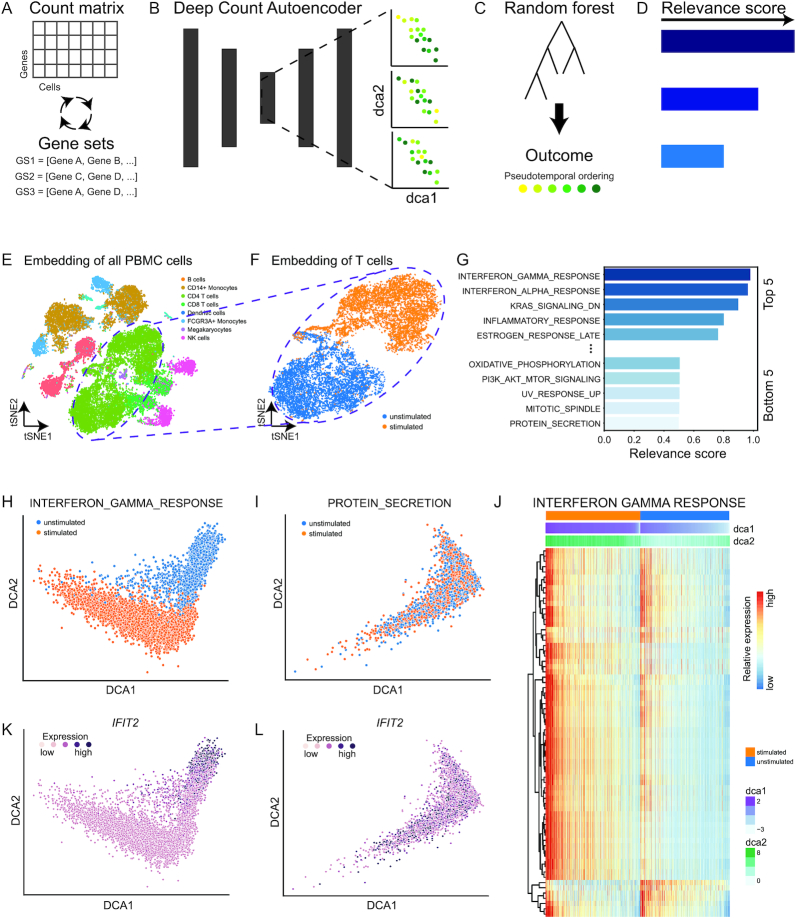
DrivAER correctly identifies interferon response. (A) DrivAER iteratively subjects annotated gene sets to unsupervised dimension reduction via Deep Count Autoencoder (DCA). (B) For each gene set, the 2D data manifold coordinates are calculated and (C) subsequently used as input features in a random forest model to predict the outcome of interest (i.e., pseudotemporal ordering). (D) The random forest prediction accuracy represents the relevance score. (E) t-Distributed stochastic neighbor embedding (tSNE) visualization displays all peripheral blood mononuclear cells (PBMCs) colored by cell type. NK: natural killer. (F) Cellular map (tSNE) of T cell subset clusters by stimulation status. (G) Bar plot indicates relevance scores of the 5 most and least relevant transcription programs. DCA embeddings calculated based on “INTERFERON_GAMMA_RESPONSE” (H) and “PROTEIN_SECRETION” (I) (negative control) gene sets are depicted. Cells are colored by stimulation status. (J) Heat map shows gene expression of “INTERFERON_GAMMA_RESPONSE” target genes and cells in rows and columns, respectively. Columns are ordered first by stimulation status and second by DCA coordinates. Bars on top of the heat map represent stimulation status and DCA coordinates 1 and 2. Red and blue colors correspond to high and low relative expression values. Relative expression of interferon gene IFIT2 is overlaid on top of the DCA embeddings derived from “INTERFERON_GAMMA_RESPONSE” (K) and “PROTEIN_SECRETION” (L) gene sets. Dark colors indicate higher expression.